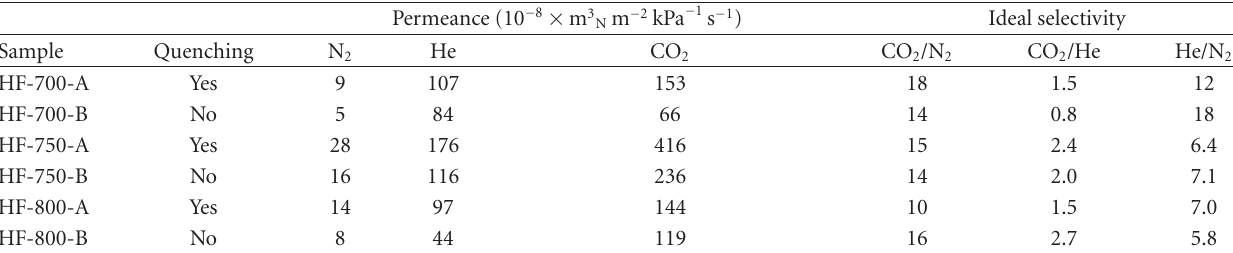
Table 4: Quenching e ff ect on the permeance of carbon hollow fibers.